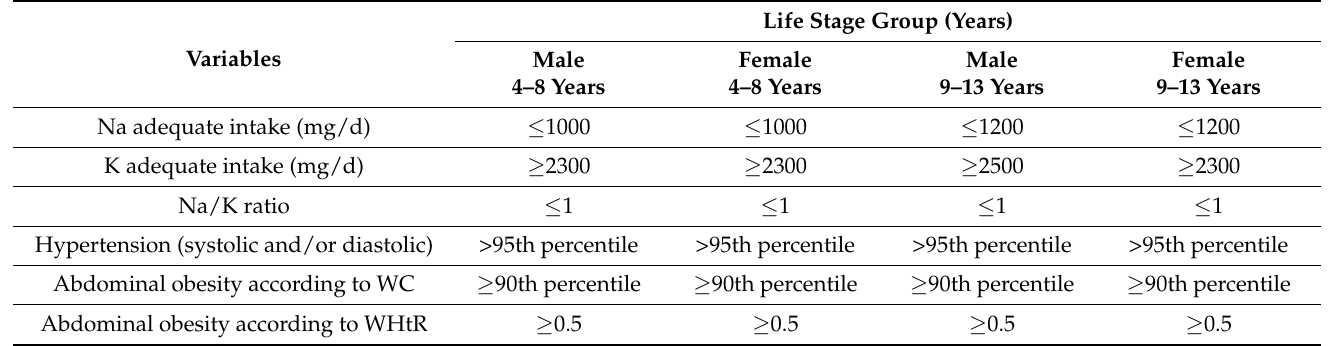
Table 1. Classification of variables according to sex and